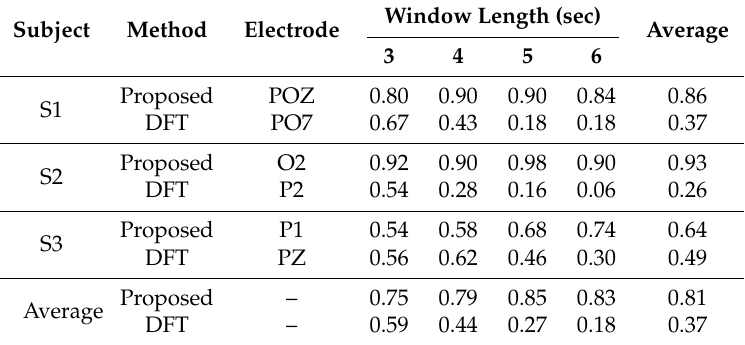
Table 4. The classification rate of each subject under different window length (Simulated 4-classes